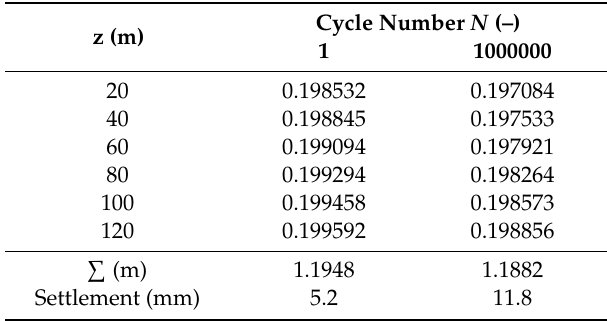
Table A8. SHML settlement calculation